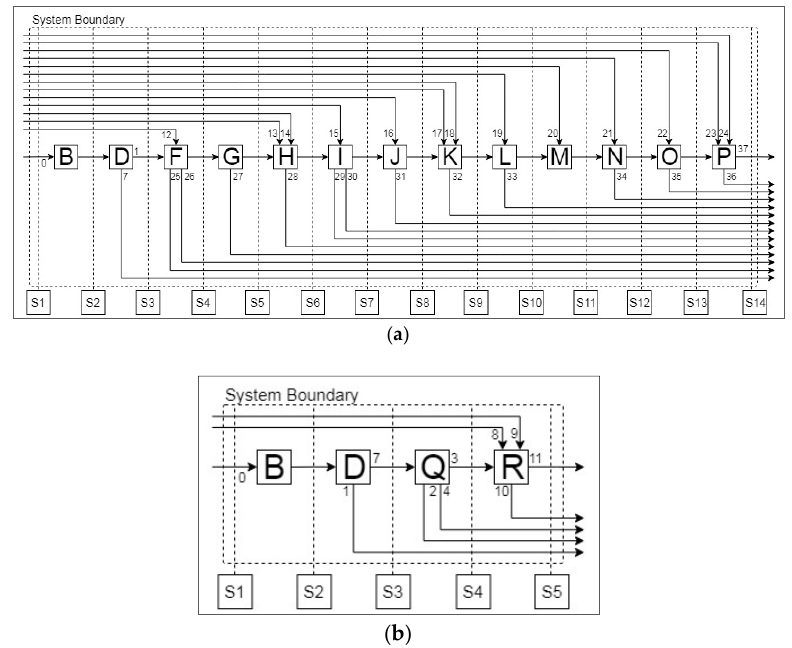
Figure 8. Electrode treatment ( a ) and Al-recovery ( b ) processes with Aalto pre-processing (PP) stages.